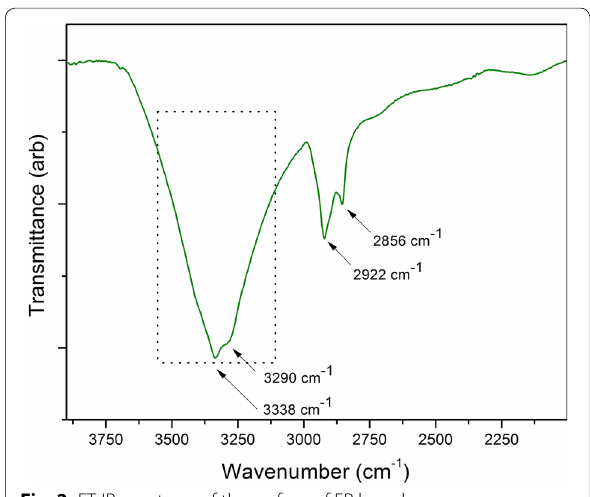
Fig. 2 FT-IR spectrum of the surface of ER